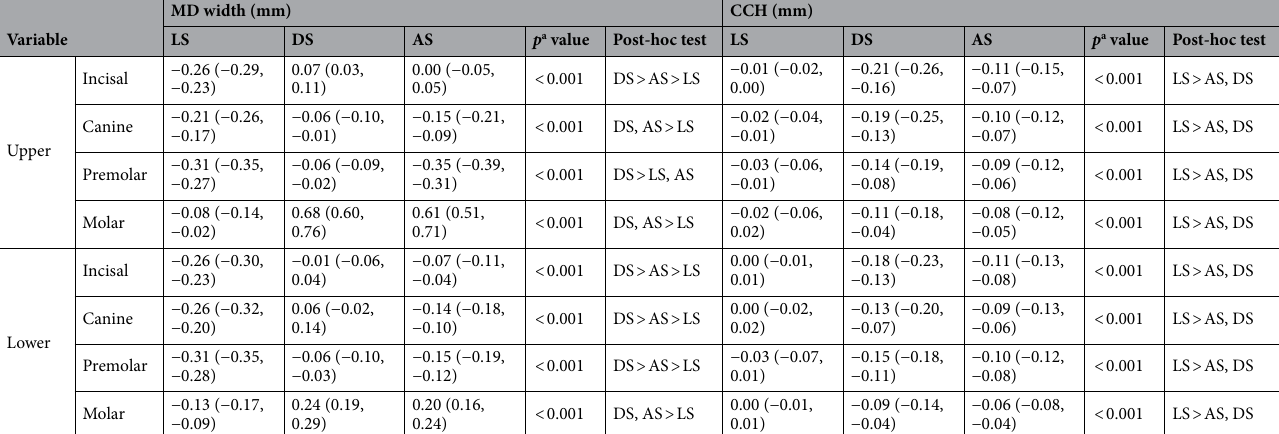
Table 5. Comparison of MD width and CCH among the three methods by tooth group. The means of the MD width error ranged from −0.31 to −0.08 mm, −0.09 to 0.68 mm, and −0.35 to 0.61) mm in the LS, DS, and AS groups, respectively. There were statistically significant differences in all tooth groups ( p < 0.001, post hoc: DS > AS > LS in upper incisal, lower incisal, lower canine, and lower premolar; DS, AS > LS in upper canine, upper and lower molar, DS > LS, AS in upper premolar). The means of the CCH error ranged from −0.03 to 0.00 mm, −0.21 to −0.09 mm, and −0.11 to −0.06 mm in the LS, DS, and AS groups, respectively. There were statistically significant differences in all tooth groups ( p < 0.001, post hoc test: LS > DS, AS). Data are given as the mean (95% confidence interval). a p values were derived from Friedman test; Shapiro–Wilk’s test was employed to test the normality assumption; * p < 0.05.